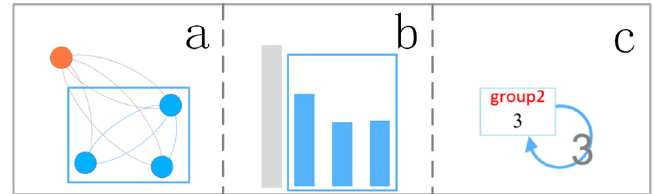
Figure 10. Diagrams of selection of interest region, ( a ) node-link diagrams; ( b ) histograms of degree; ( c ) interaction